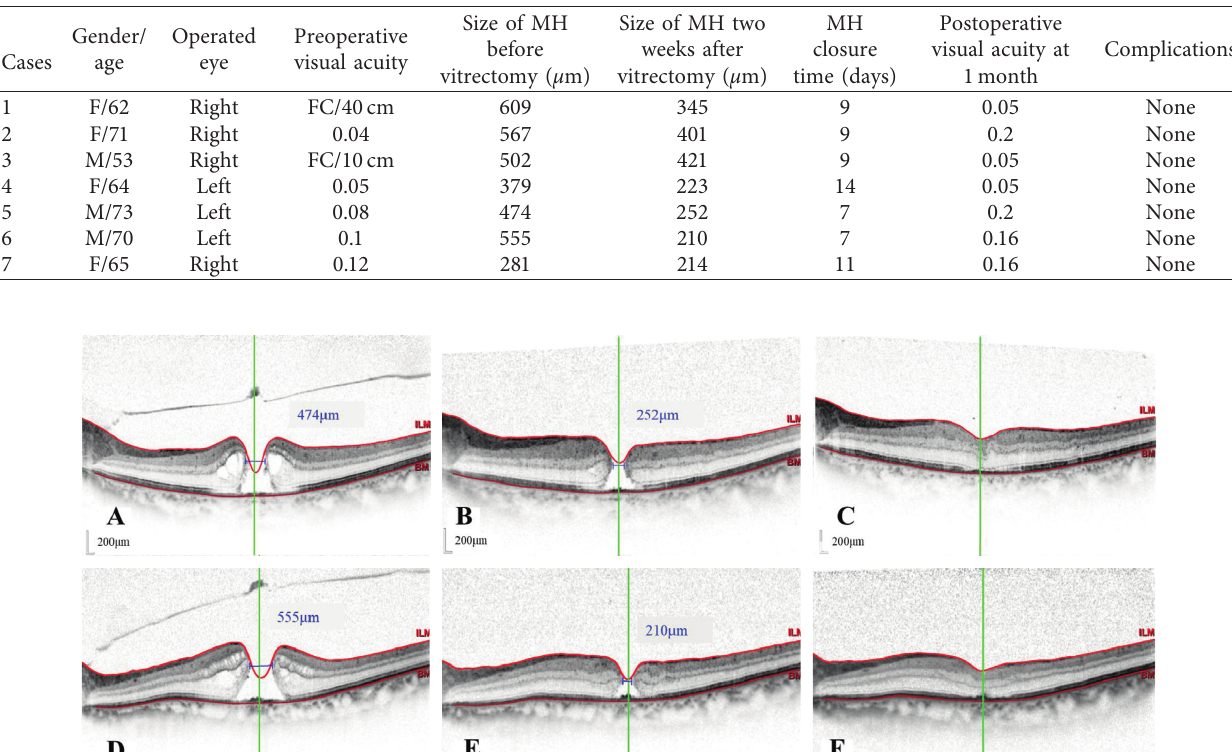
Table 1: Baseline characteristics and postoperative surgical outcome of each patient.